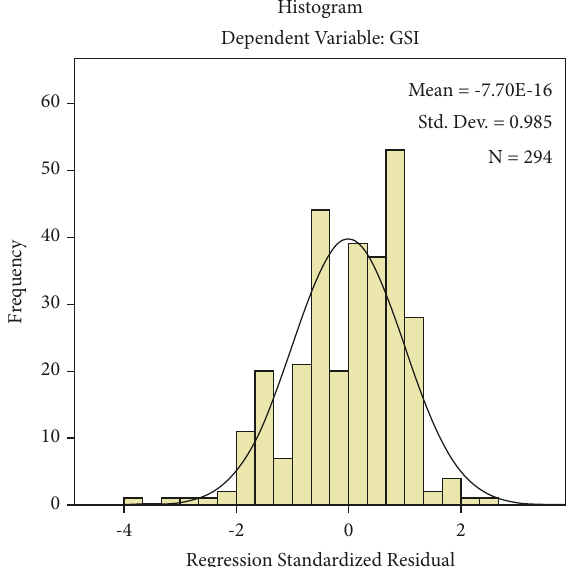
Figure 6: Histogram of regression standardized residual.